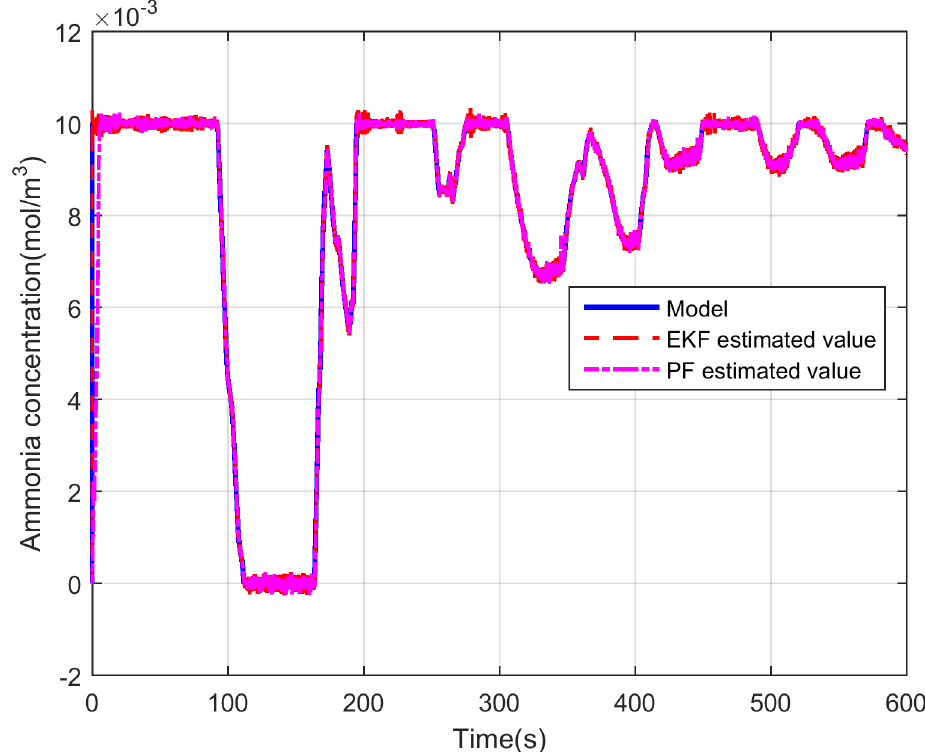
Fig 6. Comparisons of model predicted ammonia concentration and PF estimated ammonia